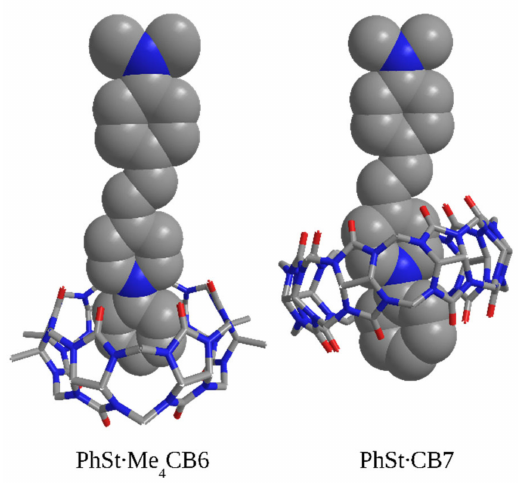
Figure 11. Theoretically calculated structures of the complexes PhSt-CB